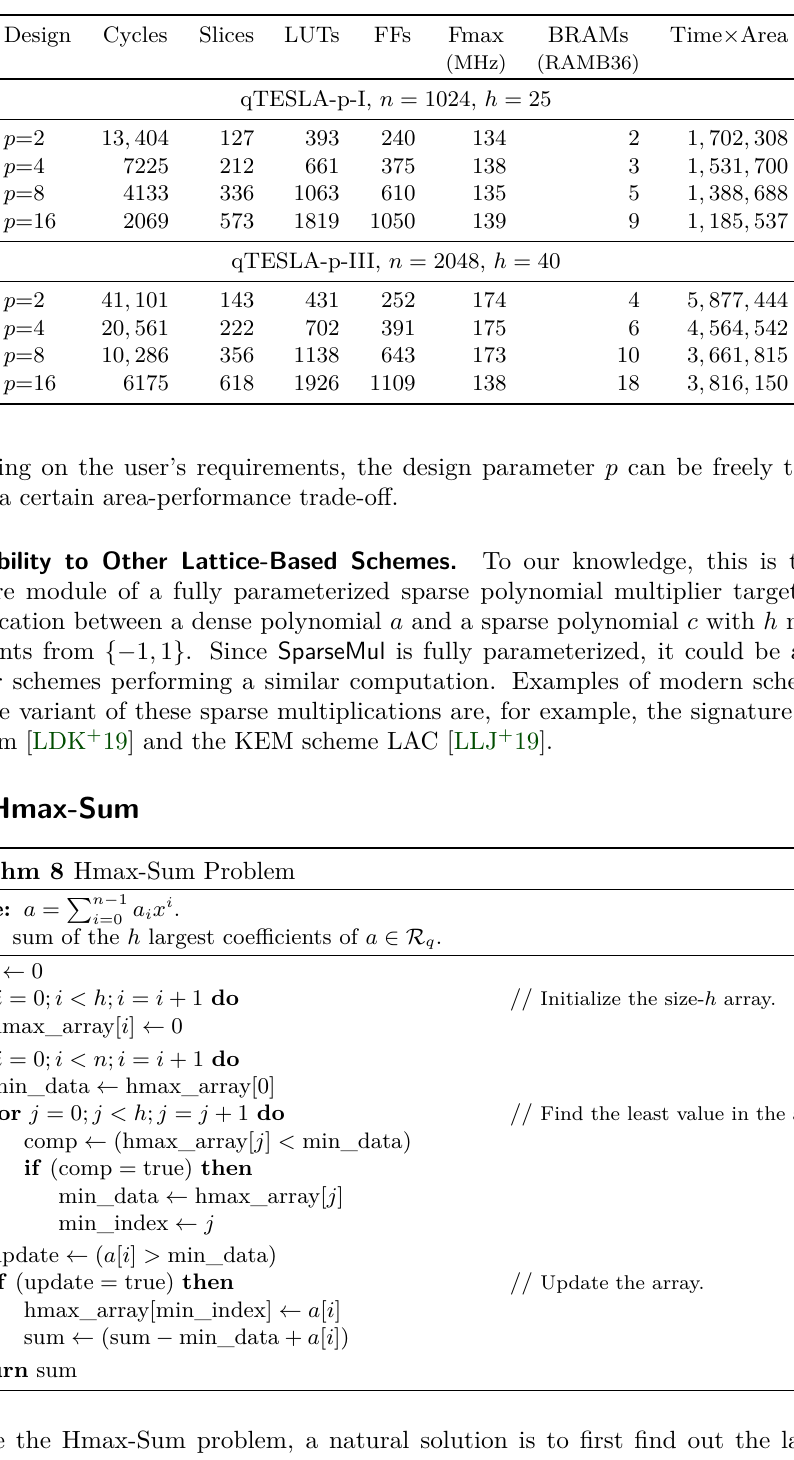
Table 6: Performance of the hardware module SparseMul .